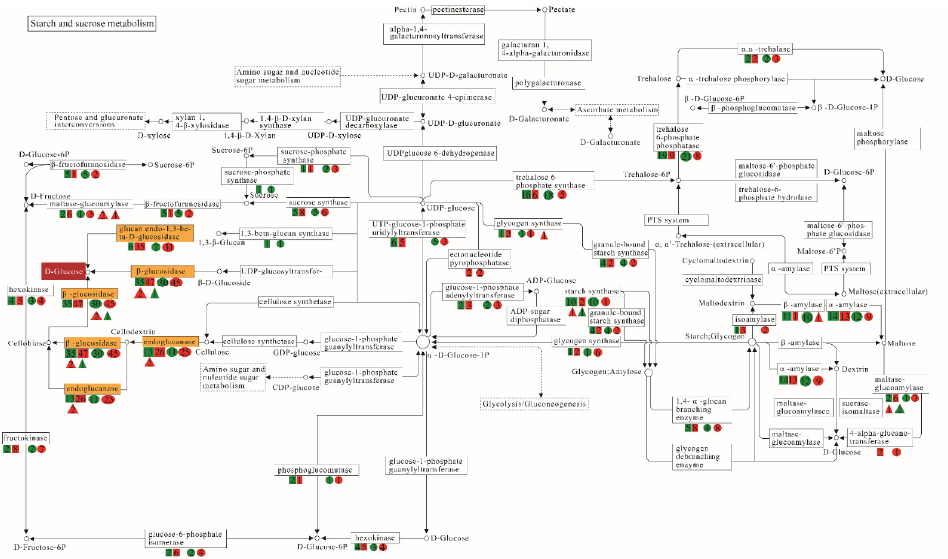
Figure A4. DEGs in starch and sucrose metabolism. Squares indicate DEGs based on the comparison between gall vs. LWG; circles indicate DEGs based on the comparison between gall vs. LNG; triangles indicate DEGs based on the comparison between LNG vs. LWG. Red color represents up-regulation and green color represents down-regulation. The numbers within shaded shapes indicate the number of genes. There were 203 genes up-regulated and 157 genes down-regulated based on the comparison between gall vs. LWG; 178 genes up-regulated and 140 genes down-regulated based on the comparison between gall vs. LNG; and 10 genes up-regulated and four genes down-regulated based on the comparison between LNG vs. LWG. DEGs encode β -glucosidase (47 genes up-regulated and 35 genes down-regulated in LWG vs. gall) and the glucan endo-1,3- β - D -glucosidase, both of which participate in D -glucose synthesis.